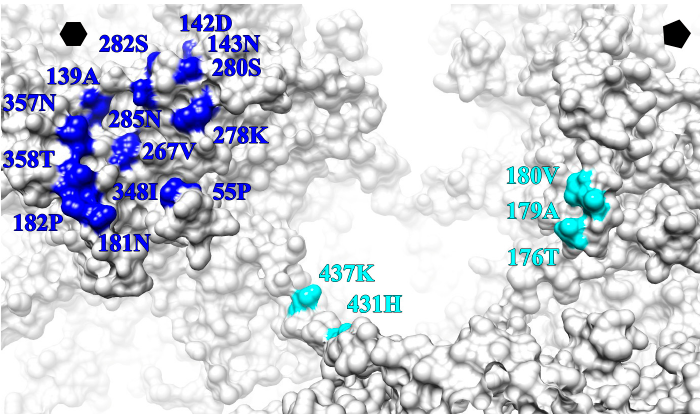
Figure 8. Zoomed view of a surface rendered HPV16 capsid (grey) map illustrates the epitope of V5 (blue) and U4 (cyan) on the surface. The V5 epitope is shown mapped to the hexavalent (hexagon) capsomer, whereas the U4 epitope lies between the hexavalent and pentavalent (pentagon) capsomers. Table 5. Residues that comprise the conformational epitopes of V5 and U4. Residues from neighboring L1 protein was designated by X ′ .